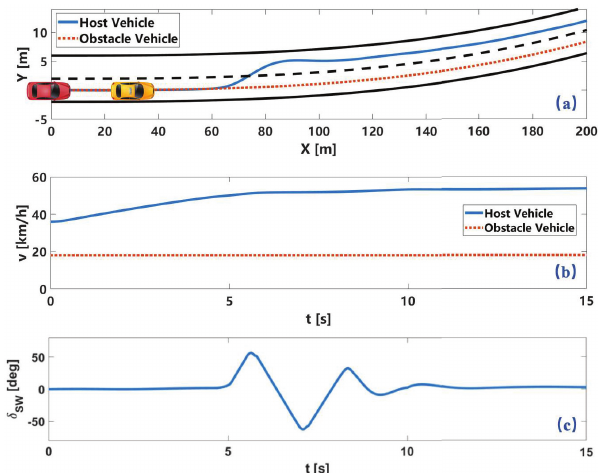
Figure 10. Simulation results of obstacle avoidance on winding lane. Here, ( a ) is vehicle trajectory. ( b ) is vehicle velocity. ( c ) is steering wheel angle.